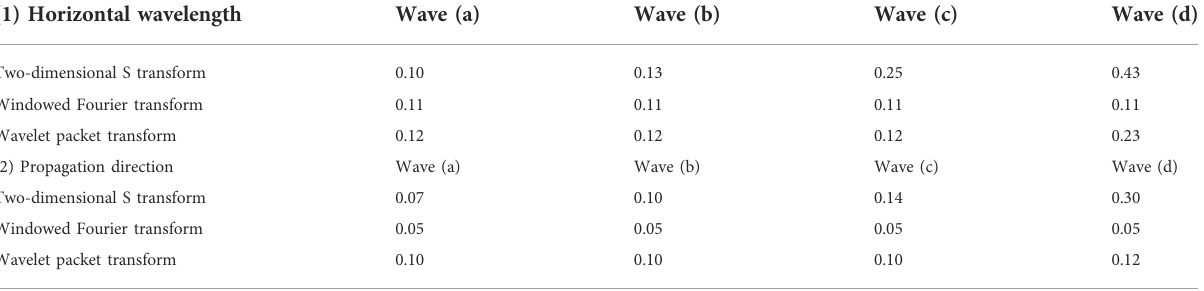
TABLE 1 Calculation errors of internal wave fringe in Figure 4 relative to (A) horizontal wavelength and (B) propagation